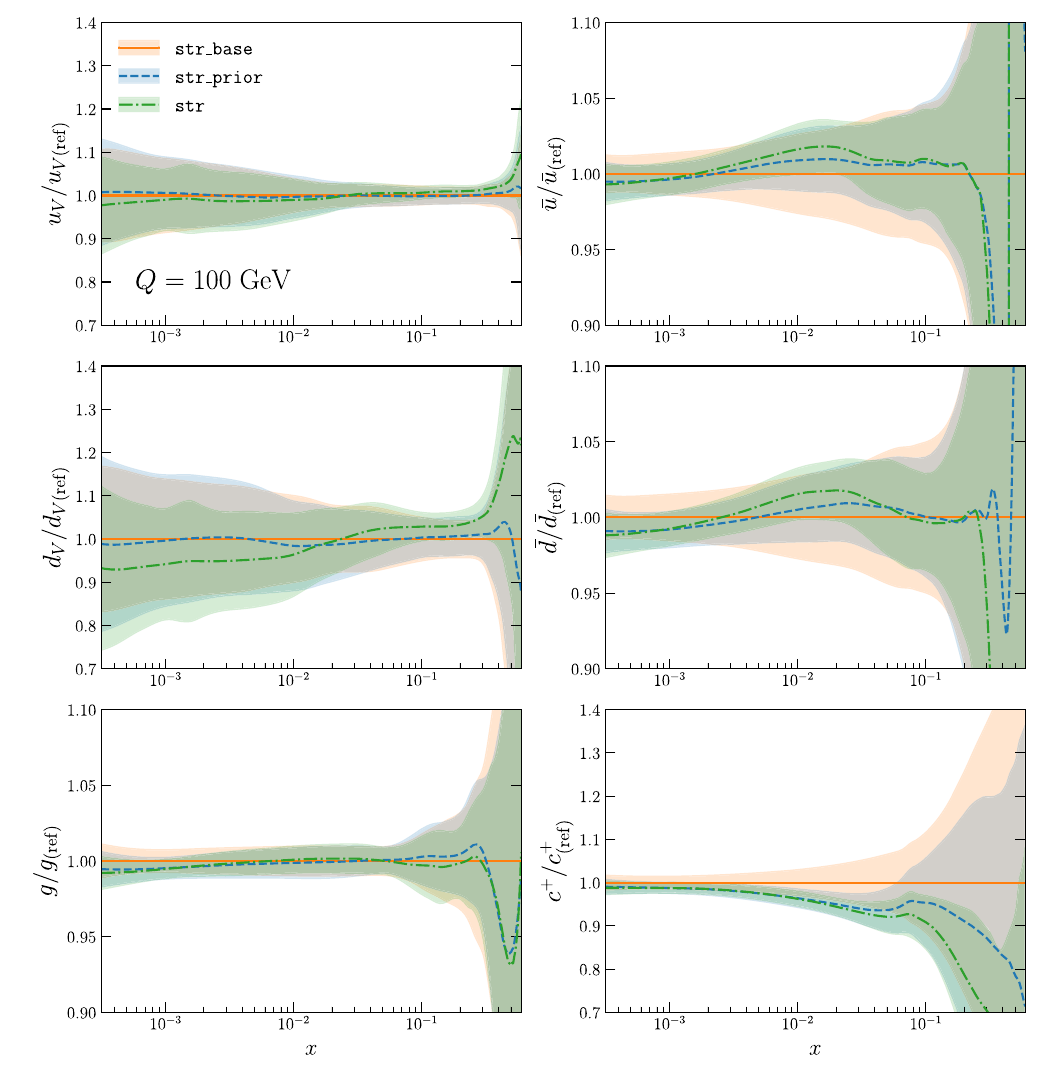
Fig. 7 Comparison between the fits presented in this work. From top to bottom and left to right we show the up (valence and sea), down (valence and sea), gluon and charm distributions resulting from the str_base , str_prior and str fits at Q = 100 GeV. Results are normalized to the str_base fit